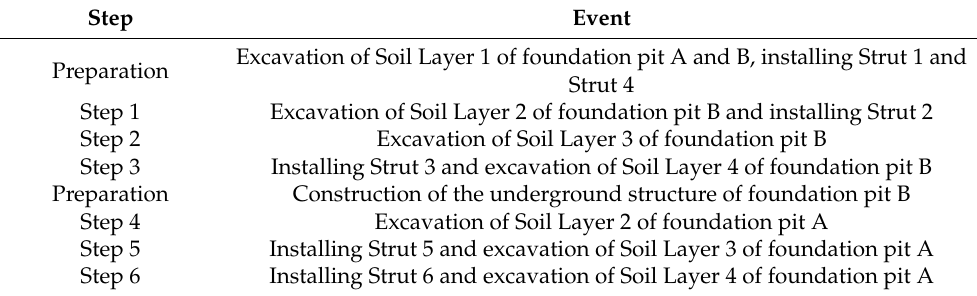
Table 3. Definition of each excavation step.